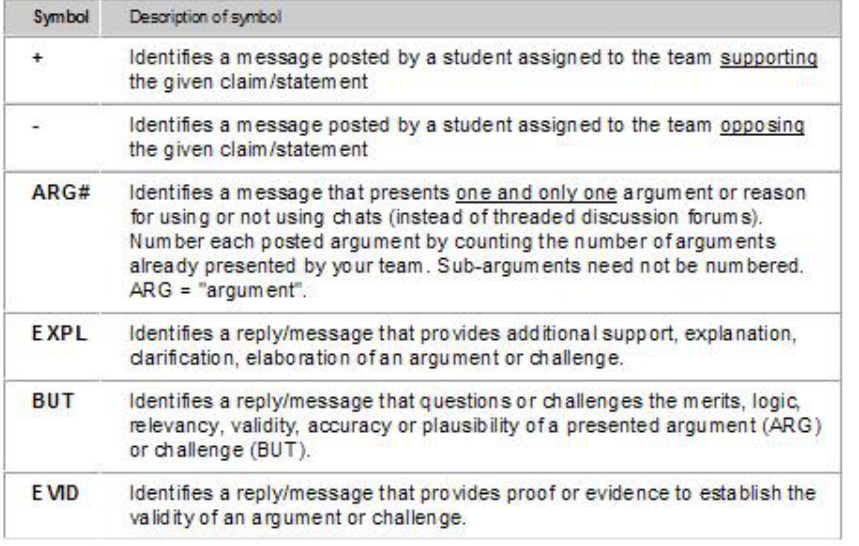
Students also identified each message by team membership by adding an “-” for opposing or a “+” for supporting team to the message labels (e.g., +ARG, -ARG). These tags enabled students to easily locate exchanges between members from opposing teams (e.g., +ARG –› -BUT)